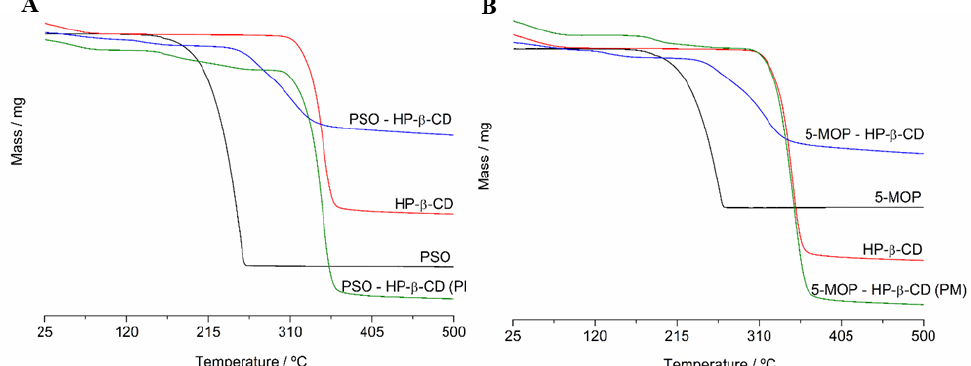
Figure 5. ( A ) TGA curves of PSO, HP- β -CD, physical mixture (PM), and PSO-HP- β -CD inclusion complex (1:1). ( B ) TGA curves of 5-MOP, HP- β -CD, physical mixture (PM), and 5-MOP-HP- β -CD inclusion complex (1:1).